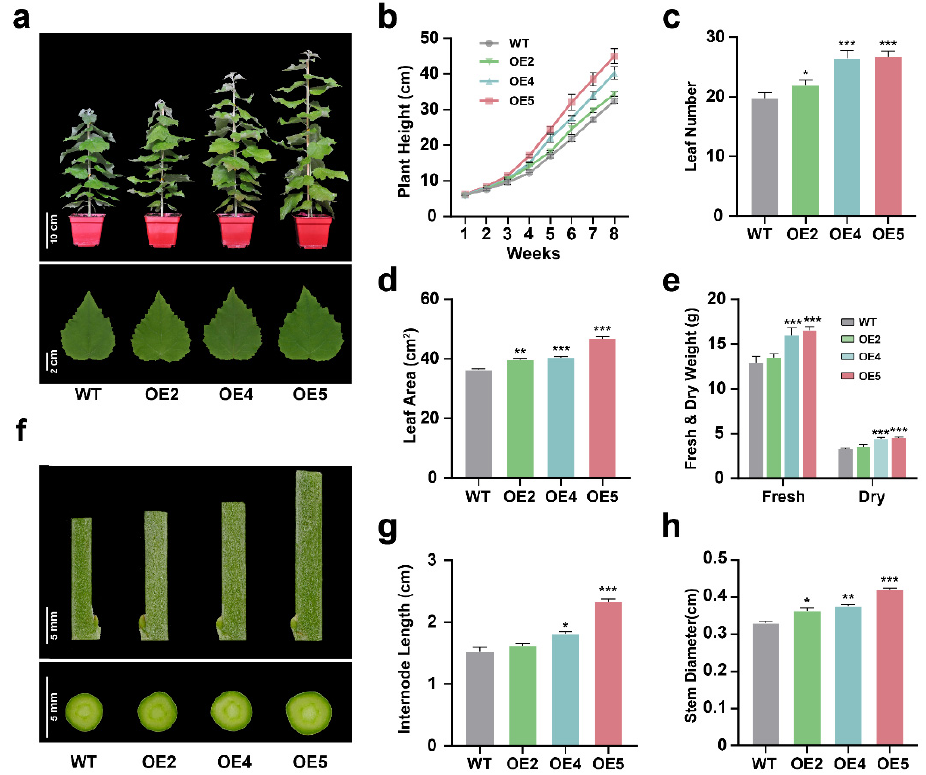
Figure 3. Growth comparisons of wild type (WT) and PtGSTF1 transgenic plants. Four-week-old plants at the same size and growth state propagated on MS medium were transferred to soil and grown in a greenhouse under the same environmental conditions for 8 weeks. ( a – e ) Plant and leaf phenotypes, plant heights, leaf numbers, leaf areas (the first fully expanded leaves from the bottom), and shoot fresh and dry weights of WT and PtGSTF1 overexpressing plants were examined. ( f , g ) Phenotypes and lengths of the 12th internodes counted from the apex. ( h ) Stem diameters. WT, wild type; OE2, OE4 and OE5, different transgenic lines. Values are the mean ± SD from five independent experiments ( n = 5). *, p < 0.05; **, p < 0.01; ***, p < 0.001.